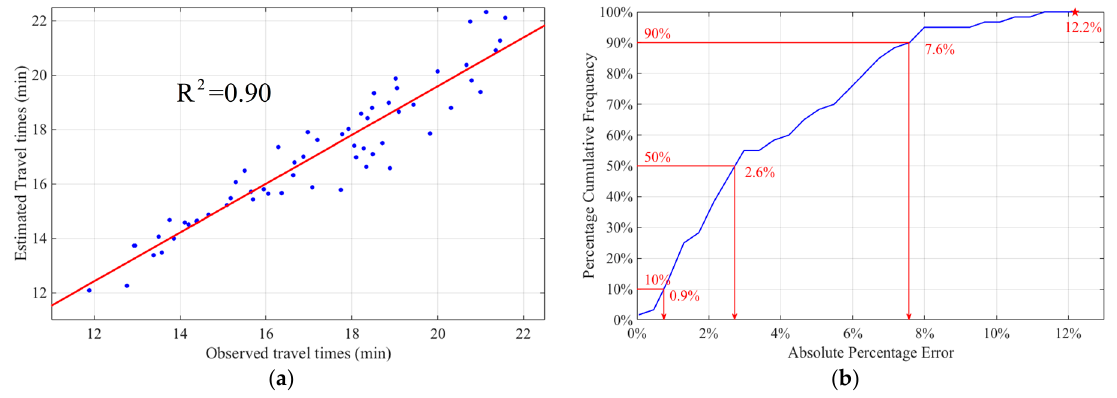
Figure 7. ( a ) Accuracy of the proposed algorithm in the fifteen-hour survey period; ( b ) Cumulative frequency distribution of the estimated errors of the mean path travel times.